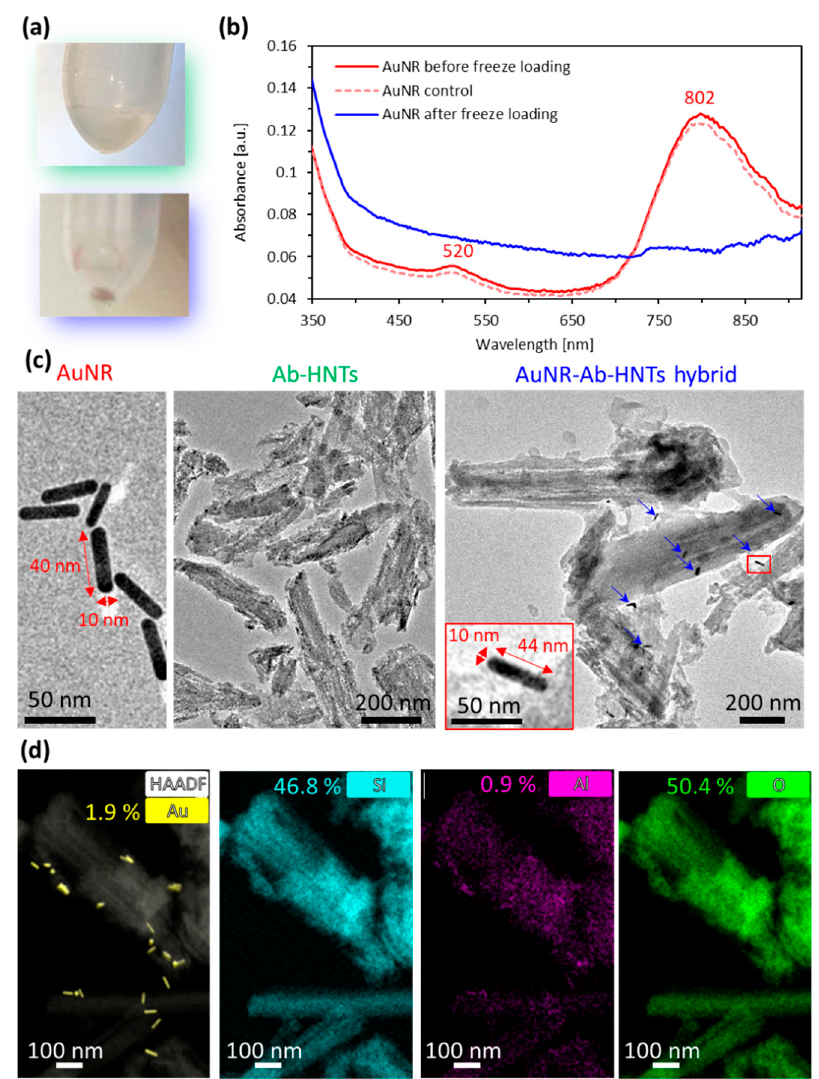
Figure 2. Incorporation of AuNRs onto Ab-HNTs. ( a ) Photographs of the Ab-functionalized HNTs (top panel) and AuNR-Ab-HNTs hybrids (bottom panel); ( b ) UV-Vis spectra at 350–920 nm of AuNR suspension before and after freezing-induced loading (red and blue traces, respectively), and a control of an AuNR suspension with no HNTs similarly processed (light red dashed trace). ( c ) TEM micrographs of: Left panel—free AuNR, red arrows indicate the measured dimensions of a gold nanorod with values detailed next to each corresponding arrow; Middle panel—Ab-HNTs without AuNRs; Right panel—AuNR-Ab-HNTs hybrids, blue arrows mark loaded AuNR, and red-frame inset depicts high magnification of the region of interest marked with a red rectangle. ( d ) STEM-EDX micrographs of AuNR-Ab-HNTs hybrid from left to right: an overlay of high-angle annular dark-field (HAADF) detector and Au elemental mapping; separate elemental mapping for Si, Al, and O. The measured wt.% of each element is indicated next to the element